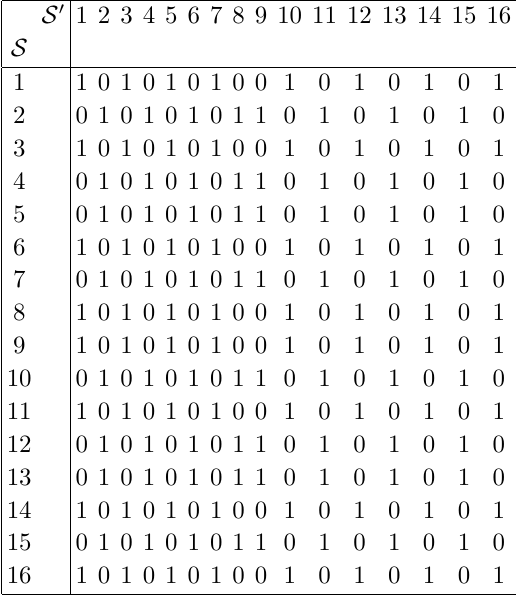
(cid:2) P with di(cid:11)erent boolean factors. [4] [5]